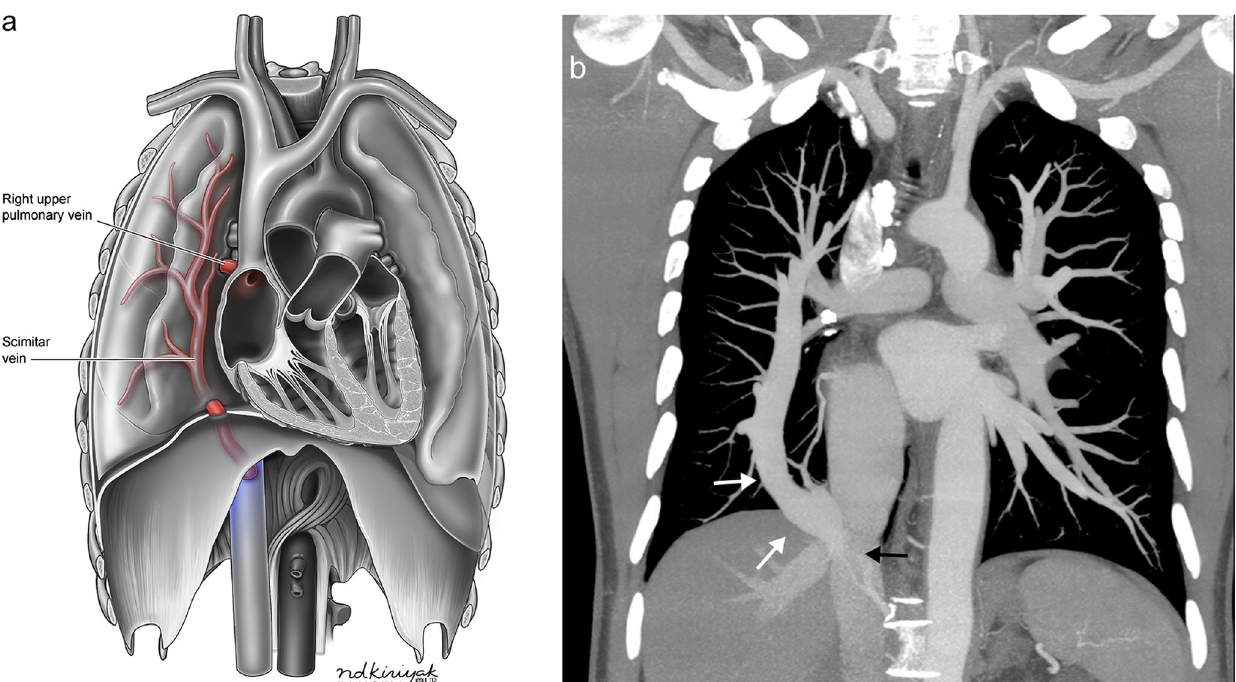
Fig. 13 Scimitar syndrome. a Conceptual illustration of scimitar syndrome. b Coronal contrast-enhanced CTof an adult patient with scimitar syndrome showing the entire right lung pulmonary venous return ( white arrows ) draining into the inferior vena cava ( black arrow )